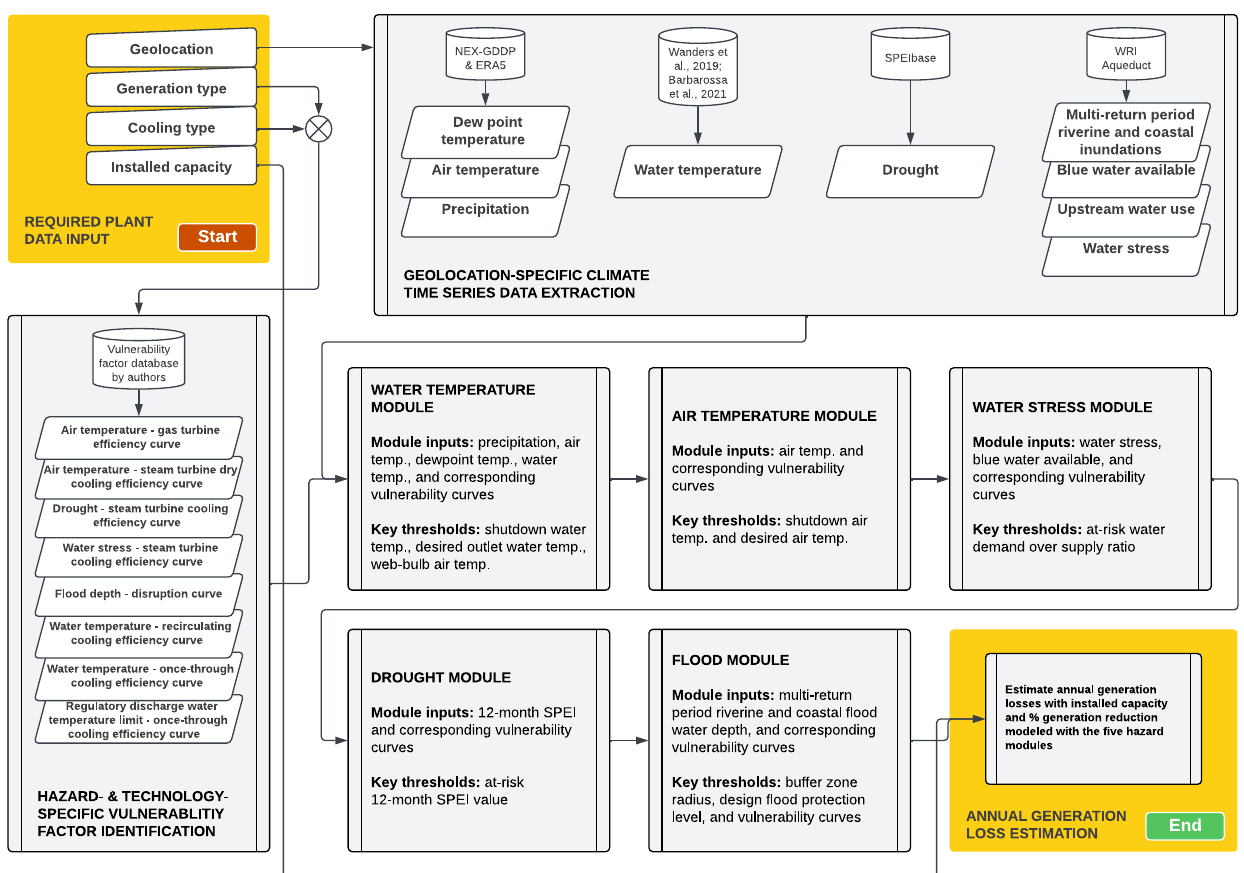
Fig. 1 Schematic representation of the power generation sector-speci fi c physical climate risk assessment model. Details on threshold setting, vulnerability factors, and modules can be found in “ Methods ”